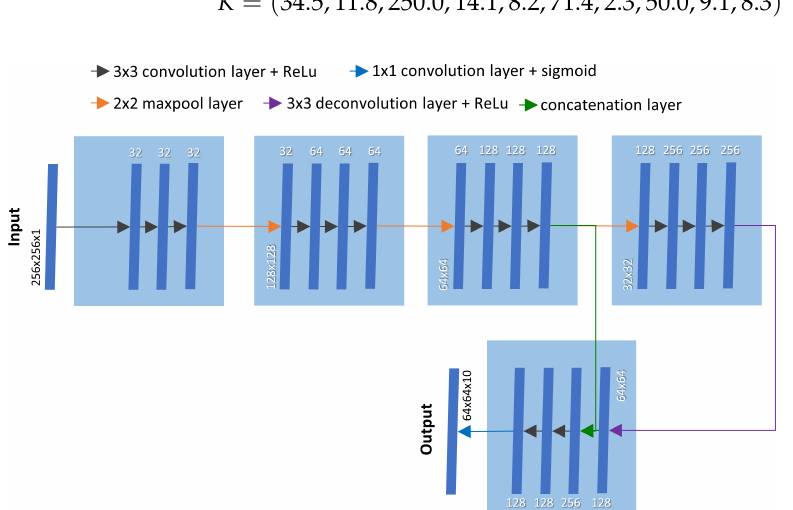
Figure 2. Architecture of the fully-supervised model. It is a UNet model [9] with a input shape fourfold the output to account for the imprecision of the